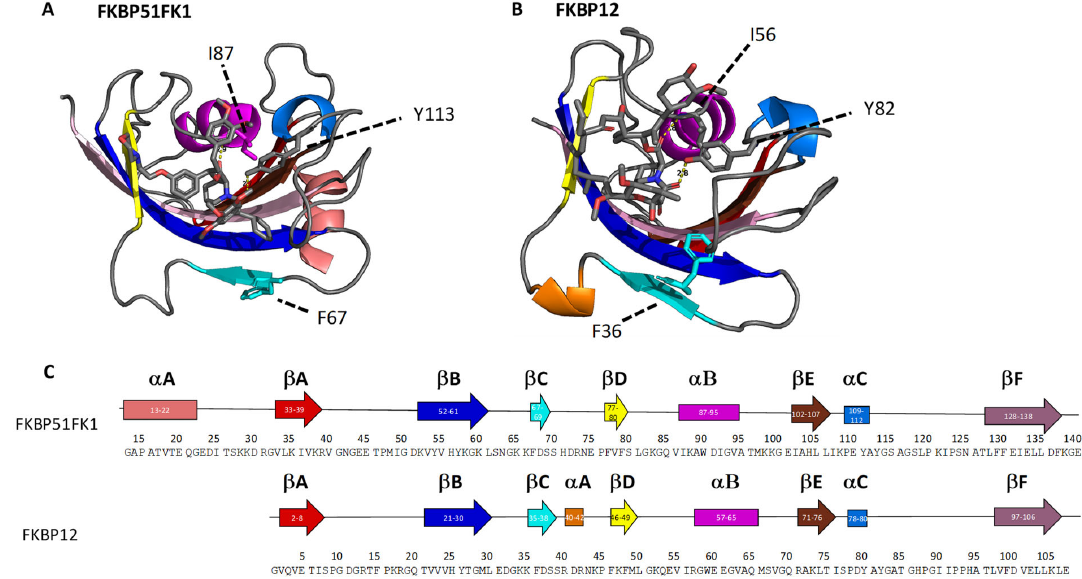
Figure 6. ( A ) Crystal structure of FKBP51FK1 in complex with the SAFit analogue iFit4 (Protein Data Bank accession code 4TW7), with key interacting amino acid residues labelled with a dashed line. ( B ) Crystal structure of FKBP12 in complex with FK506 (accession code 1FKJ), with key interacting amino acid residues labelled with a dashed line. ( C ) Sequence overview for FKBP51FK1 and FKBP12, where homologous sequence regions are aligned. Secondary structure elements are colour ‐ coded and correspond to the same colour in the crystal structures.